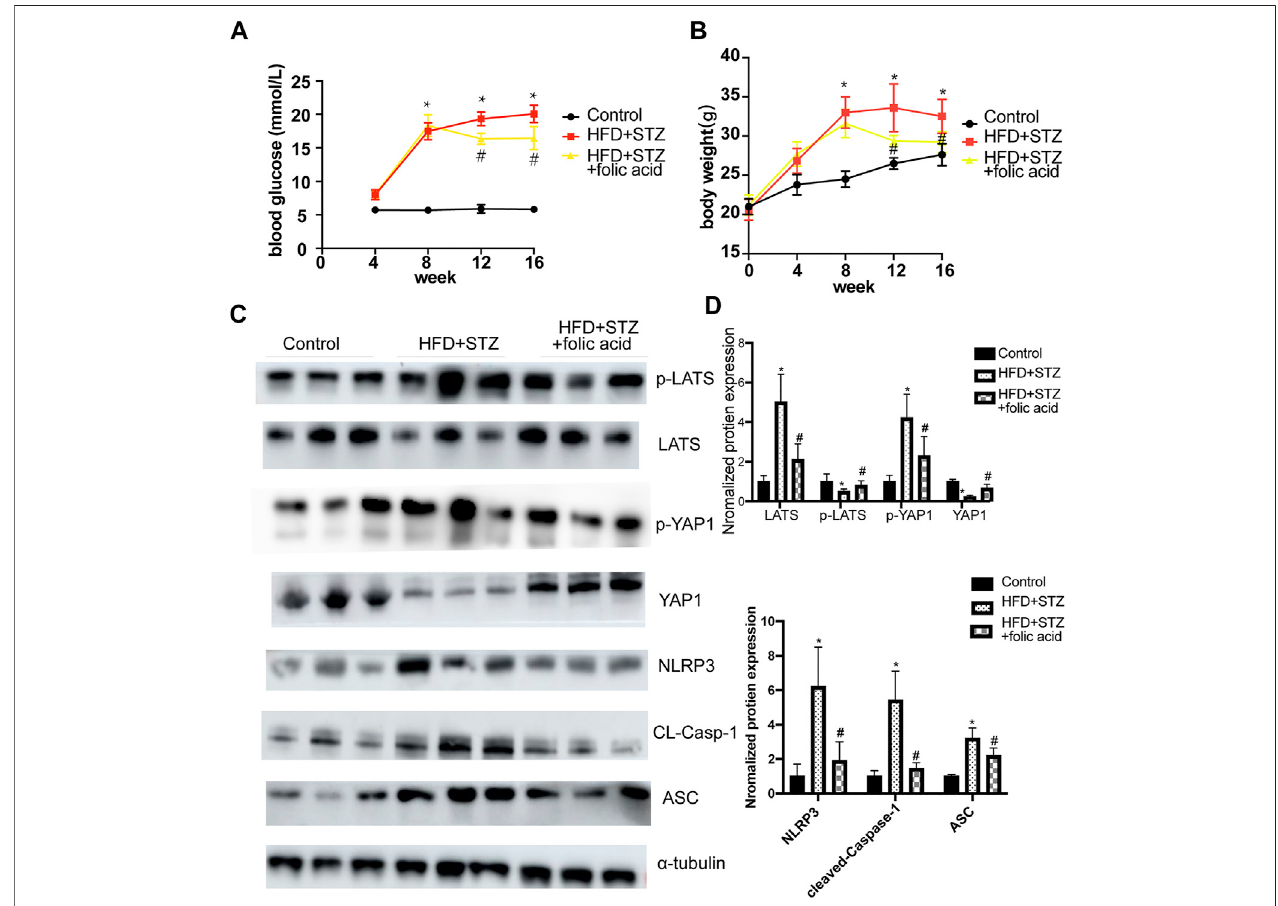
FIGURE 7 | Folic acid reduces myocardial pyroptosis by inhibiting activation of Hippo signaling pathway in HFD + STZ mice. (A) Blood glucose curve; (B) body weight curve; (C) Representative immunoblot showing levels of NLRP3, ACS, Cleaved-Caspase-1, LATS, p-LATS, YAP and p-YAP; (D) Quanti fi cation of NLRP3, ACS, Cleaved-caspase-1,LATS,p-LATS,YAP1,p-YAP1, α -tubulinwasusedastheloadingcontrol.* p < 0.05,comparedwithcontrolgroup; # p < 0.05,comparedwithHFD+ STZ group. CON: normal diet mice; HFD + STZ: HFD + STZ mice treated with PBS; HFD + STZ + folic acid: HFD + STZ mice treated with folic